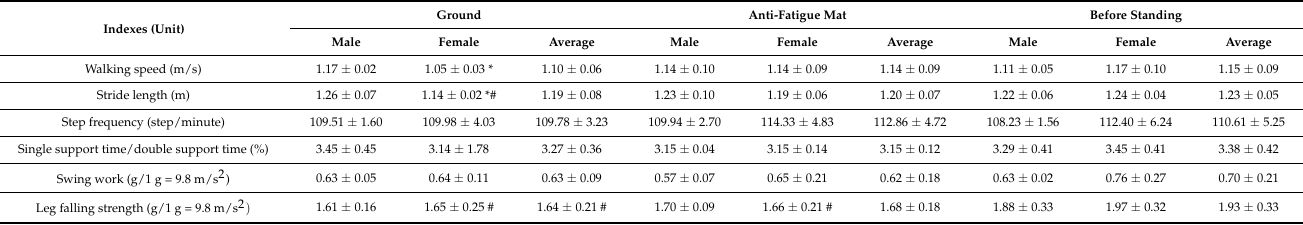
Table 2. Gait parameters after standing for 4 h on surfaces with different hardness and gender.